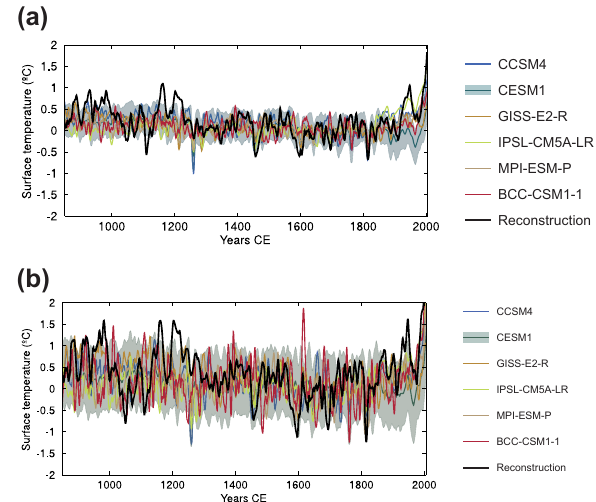
Figure 1. Summer temperature averaged over (a) Europe and (b) the Alpine region (defined here as the area between 45 and 48 ◦ N and between 6 and 13 ◦ E) in the reconstruction of Luterbacher et al. (2016) and as simulated by climate models over the past millen- nium. The shaded area represents the mean plus and minus 1 stan- dard deviation of the CESM1 model ensemble. A 15-year Lowess smoothing has been applied to the time series. The reference period is the years 1500–1850CE as in Luterbacher et al.